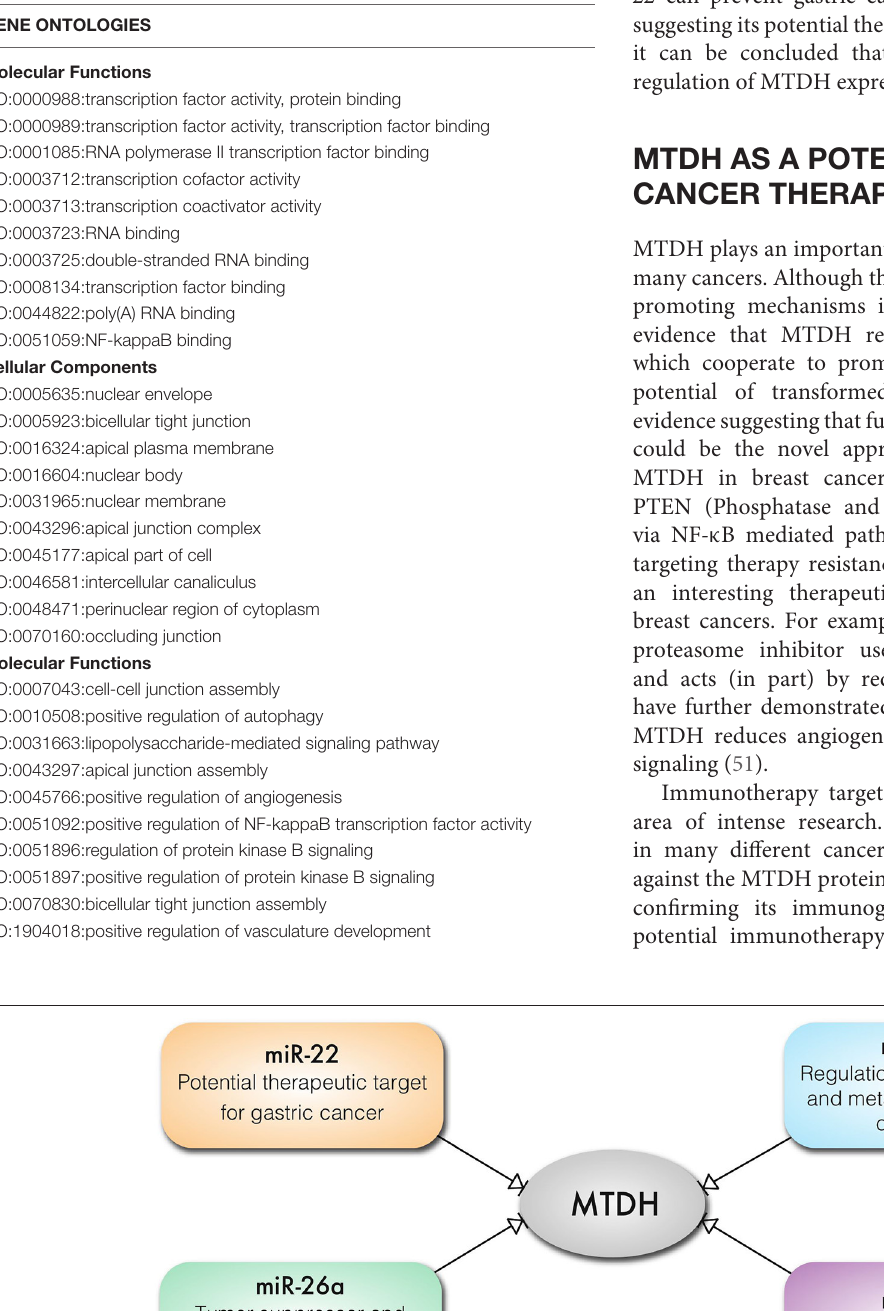
Frontiers in Oncology |